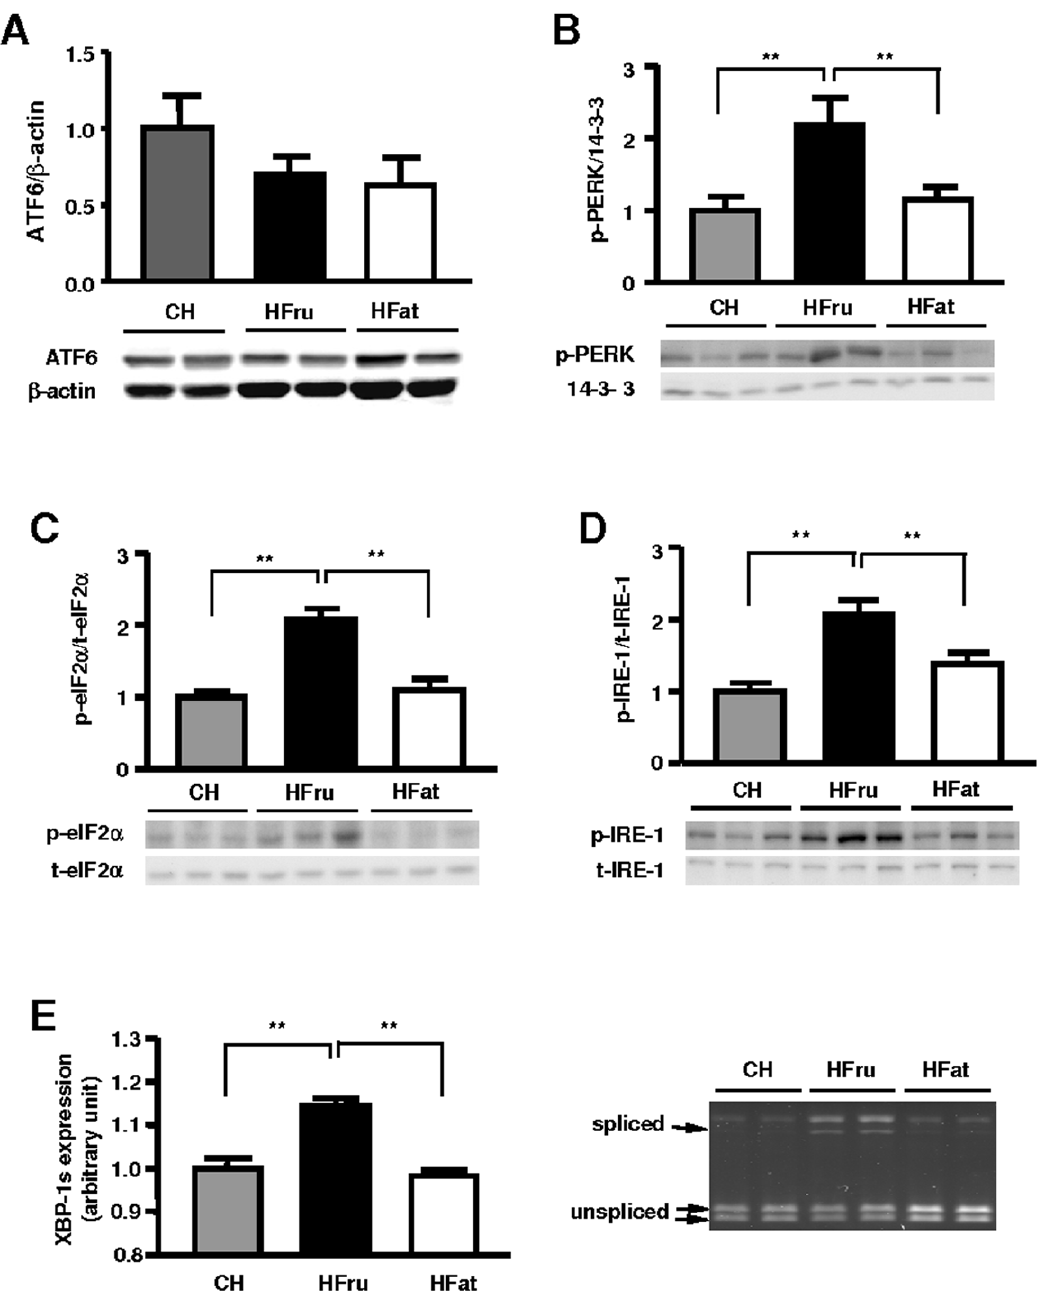
Figure 7. Effects of HFru and HFat on ER stress markers in the liver. After one week of HFru or HFat feeding, animals were fasted for 5- 7 hours before tissue collection and liver homogenates were immunoblotted for markers of ER stress. ( A ) ATF6/ b -actin (n=4/group), ( B ) p-PERK, ( C ) p-eIF2 a /t-eIF2 a , ( D ) p-IRE1/t-IRE1, and ( E ) the post-transcriptional splicing of XBP1 transcript. Each lane represents a single mouse. Densitometry data are mean 6 SE of 6 mice per group. ** p , 0.01.